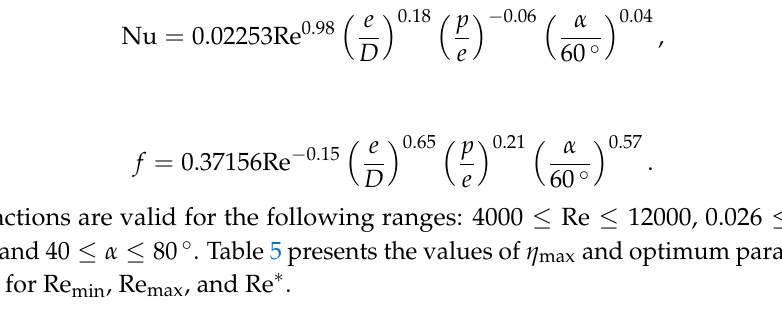
Table 4. Maximum efficiency and optimum roughness parameters according to the model developed by Kumar et al. [41]. ˙ G / ( Wm − 2 )